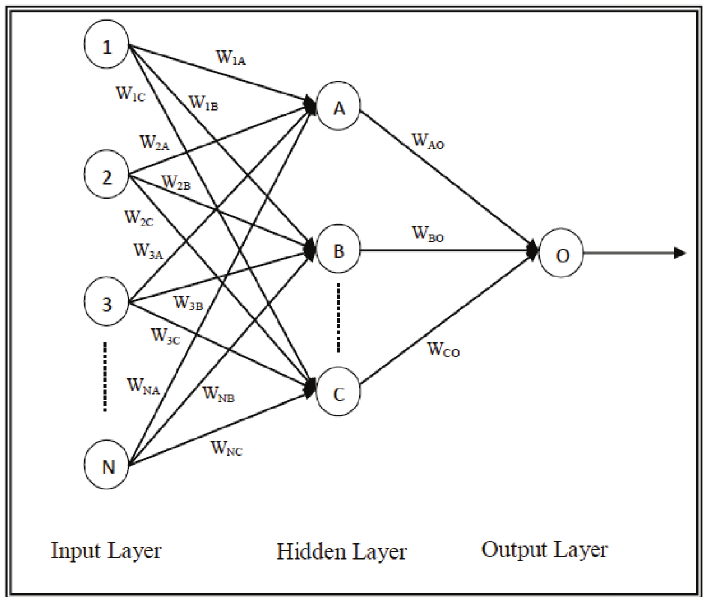
Fig.4. Sample neural